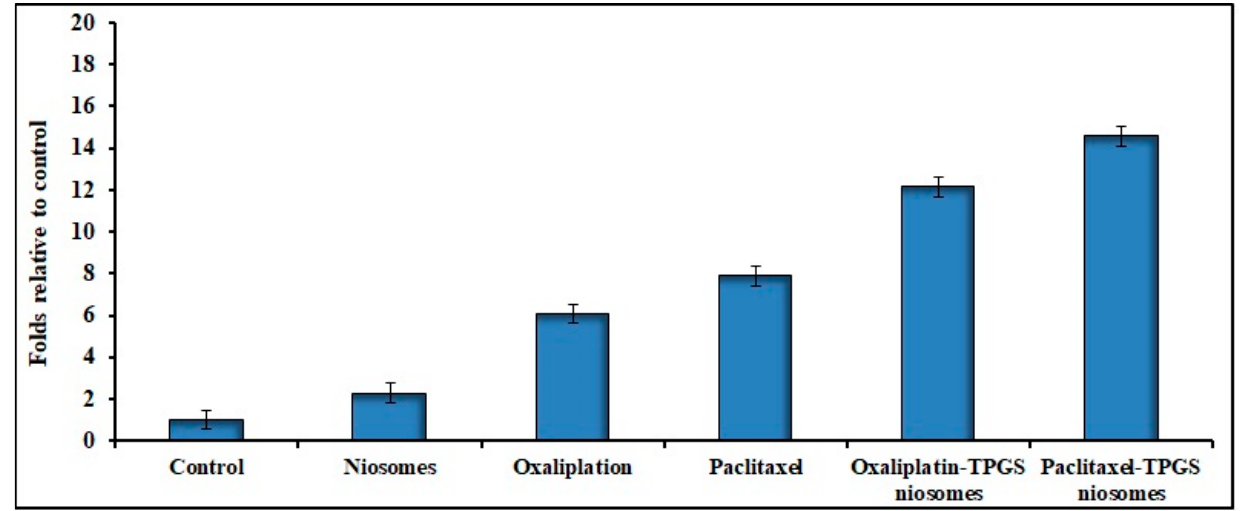
Figure 7. Effects of Oxaliplatin–TPGS–niosomes, Paclitaxel–TPGS–niosomes, drug-free niosomes (F9), Oxaliplatin solution and Paclitaxel solution therapy on apoptosis in HT-29 cancer cell line (IC 50 values μ g/mL) for 24 h treatment in HT-29 cells ( p < 0.05 compared to control).